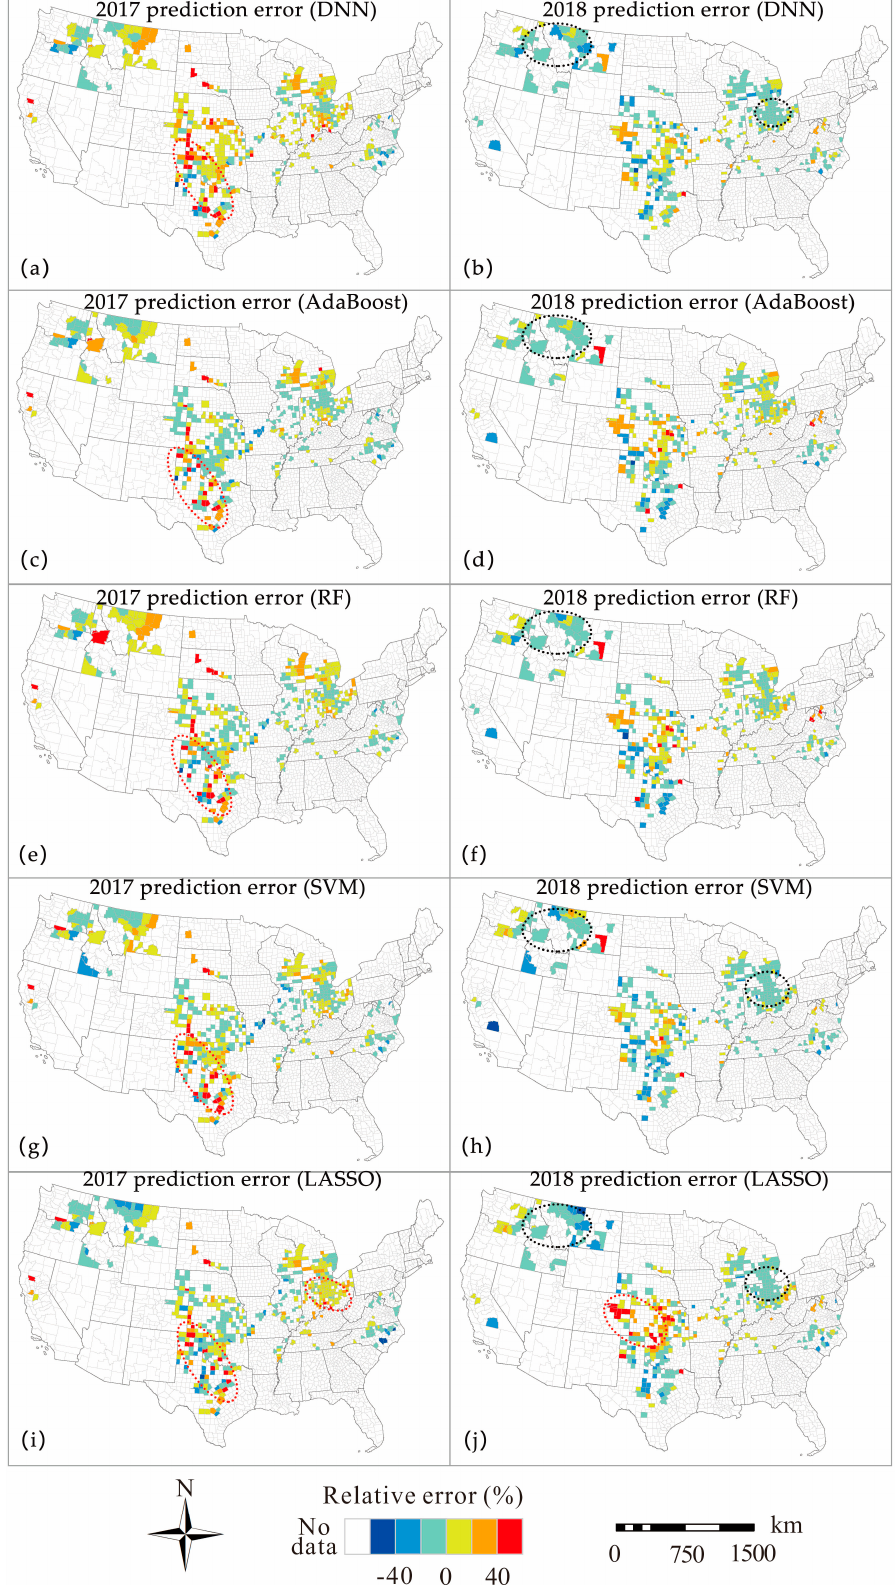
Figure 5. The spatial patterns of the relative error (the black ellipses represent the spatial aggregation of underestimation. The red ellipses represent the spatial aggregation of overestimation).